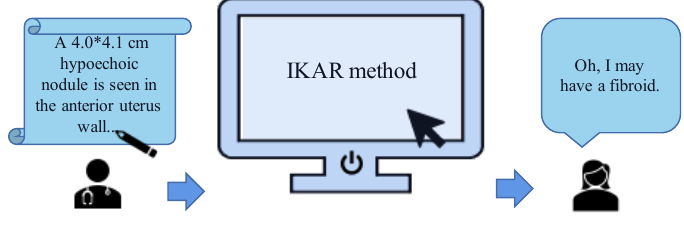
Figure 2. The task of the paper.